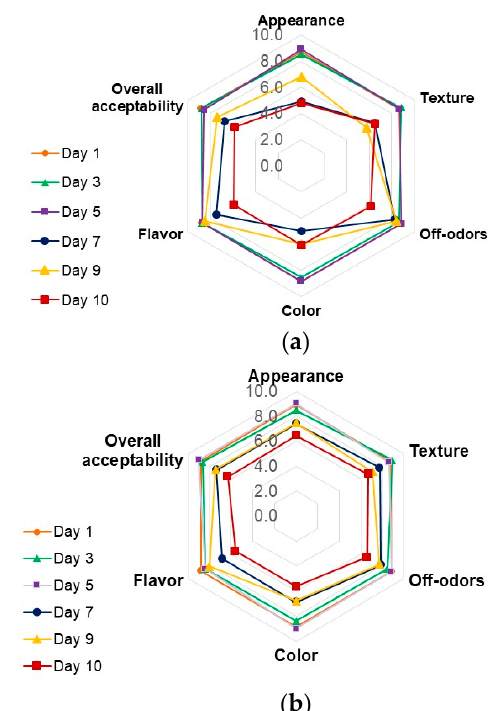
Figure 5. Sensory scores of the lettuce treated with chlorine solution ( a ) and Fermented whey ( b ) over 10 days in cold storage. Results represent the average of at least three replicate experiments (n = 3) ± SD.